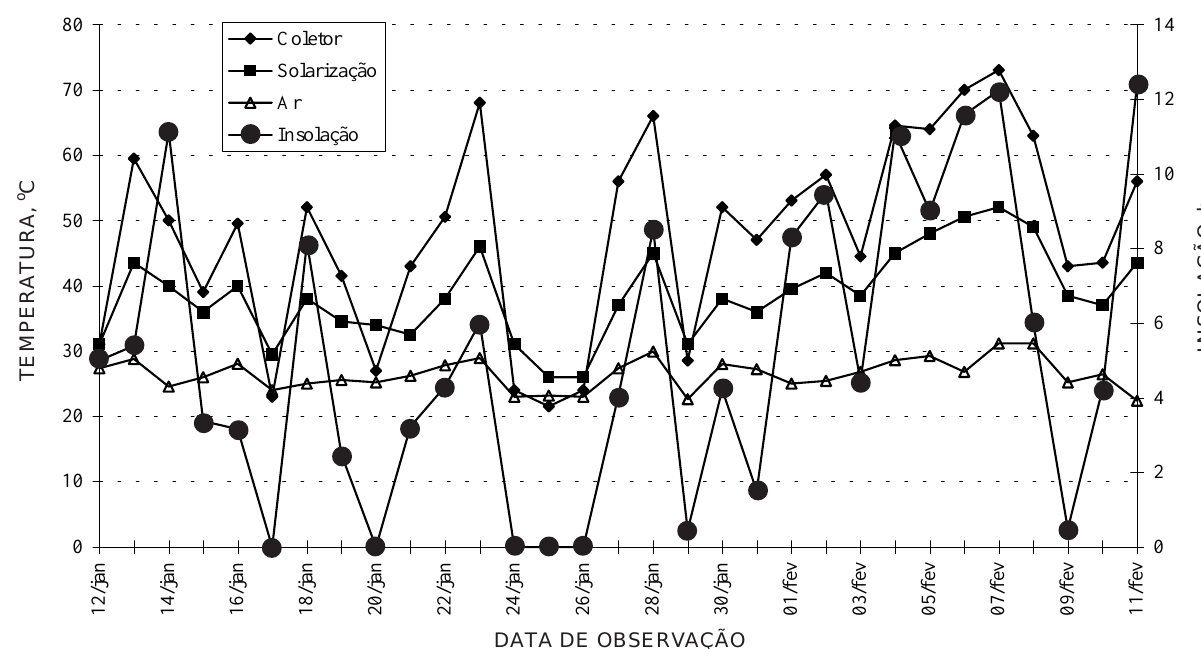
Figura 1. Temperaturas máximas do ar e do solo no coletor solar e em solarização e horas diárias de insolação no período de 12 de janeiro a 11 de fevereiro de 1996, Pelotas